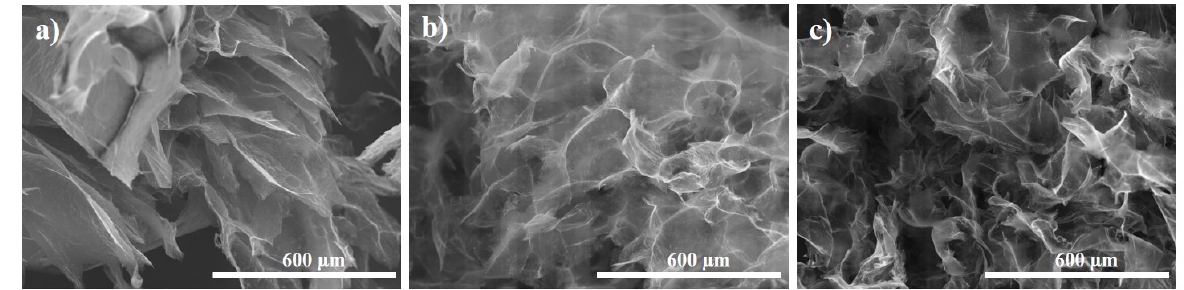
Figure 3. SEM images of modified rGO aerogels obtained: ( a ) In the absence and modified with ( b ) G3 and ( c ) G7 dendrimer.